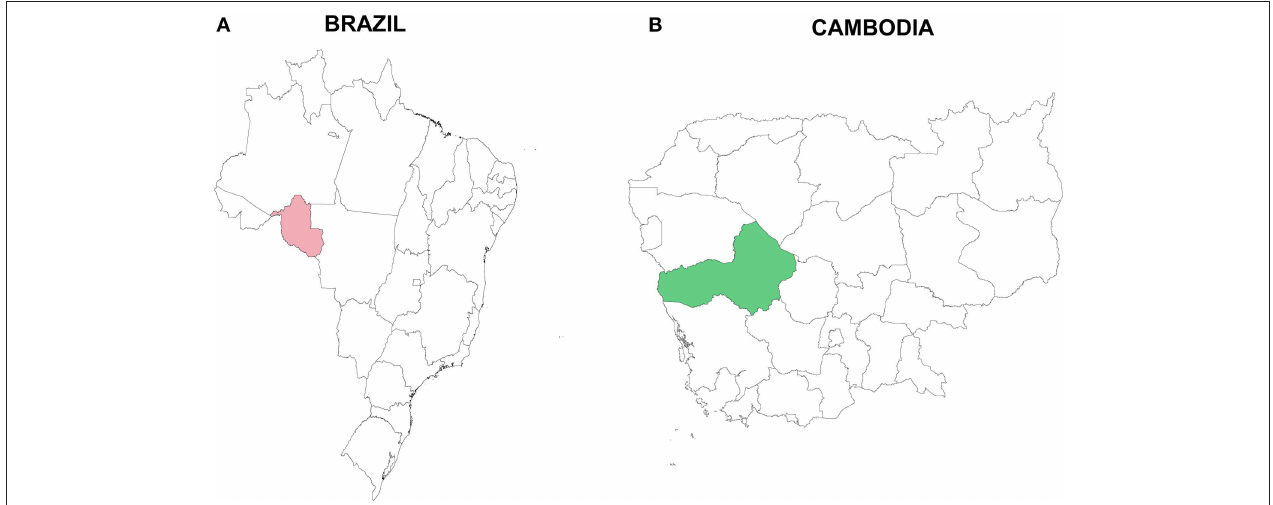
FIGURE 1 | Study sites in (A) Rondônia state, Brazil, South America (pink), and (B) Pursat province, Cambodia, Asia (green). Samples were collected in Brazil in 2011 and 2014 and in Cambodia during 2010.